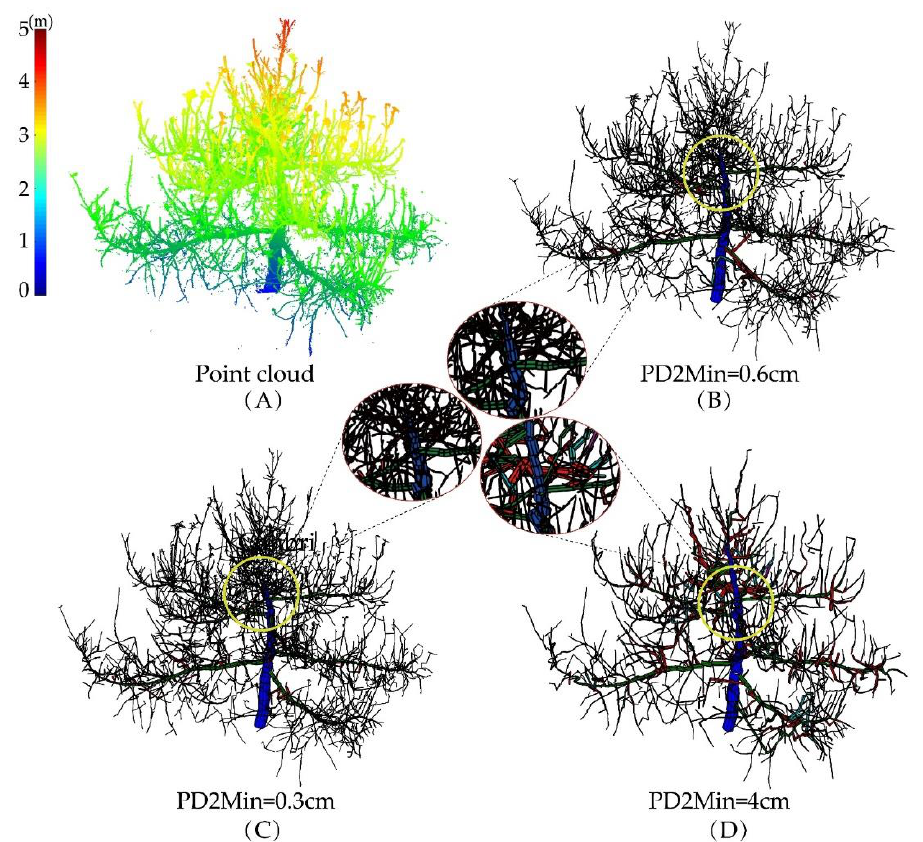
Figure 6. Comparison of QSMs when the sensitive parameter PD2Min is set at different values. In this example, PD1 = 10 cm, PD2Max = 5 cm, Lycl = 3, FilRad = 3.5. ( A ) TLS point cloud of tree 6; ( B ) QSM when parameter PD2Min = 0.6 cm; ( C ) QSM when the parameter PD2Min = 0.3 cm; ( D ) QSM when the parameter PD2Min = 4 cm. The color of QSMs indicates the branch orders: Blue = trunk, Green = first-order branches, Red = second-order branches, etc.